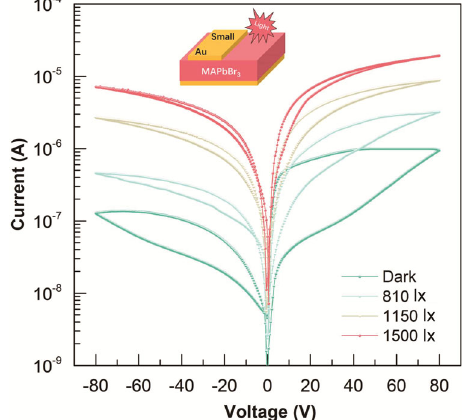
Fig. 7 I – V curves of an Au/MAPbBr 3 /Au device under light illumination with selected power